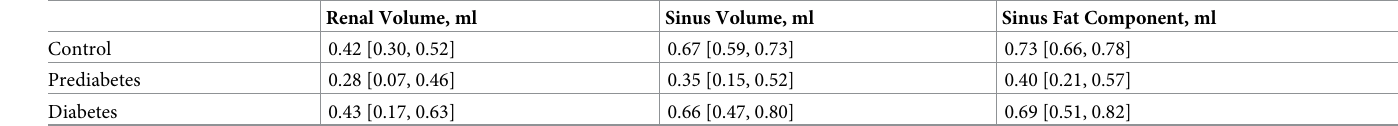
Table 5. Pearson’s correlation coefficients of VAT and renal volumes with corresponding 95% CI stratified by glycemic status.